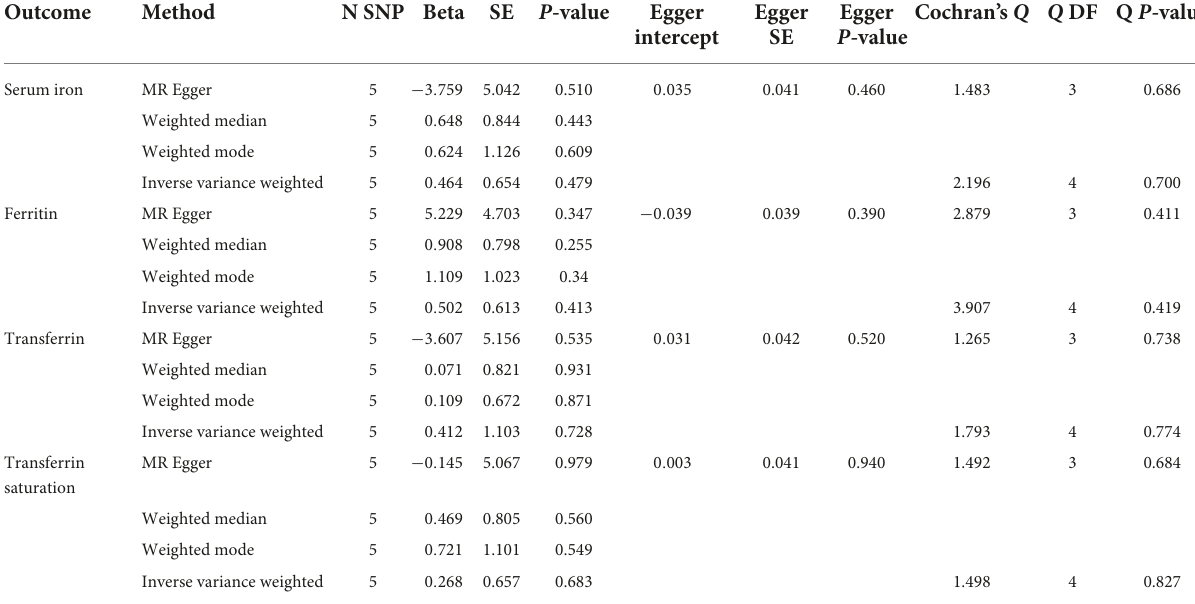
TABLE 6 Mendelian randomization estimates for the causal effect of back pain on iron status biomarkers.